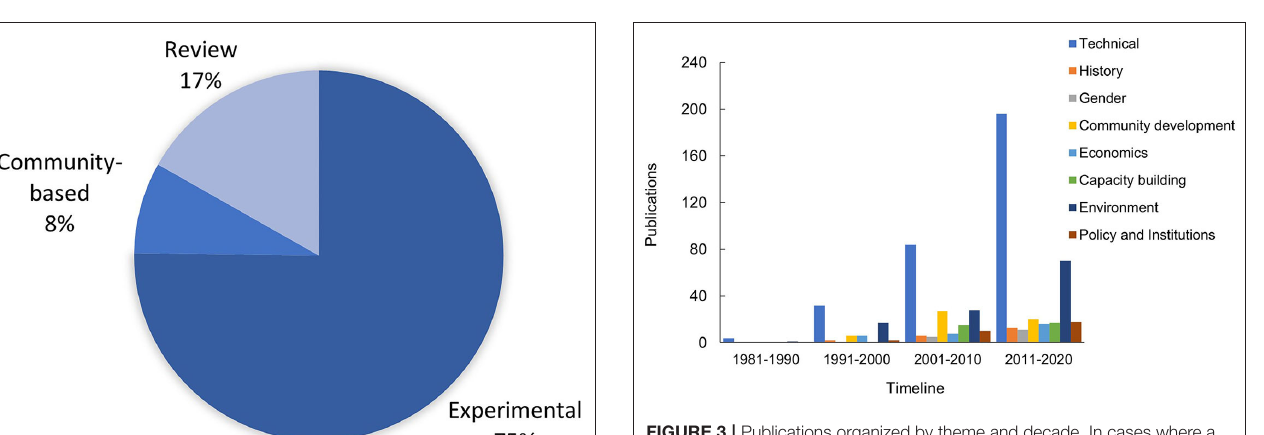
FIGURE 3 | Publications organized by theme and decade. In cases where a publication addresses more than one theme, it was added to more than one relevant